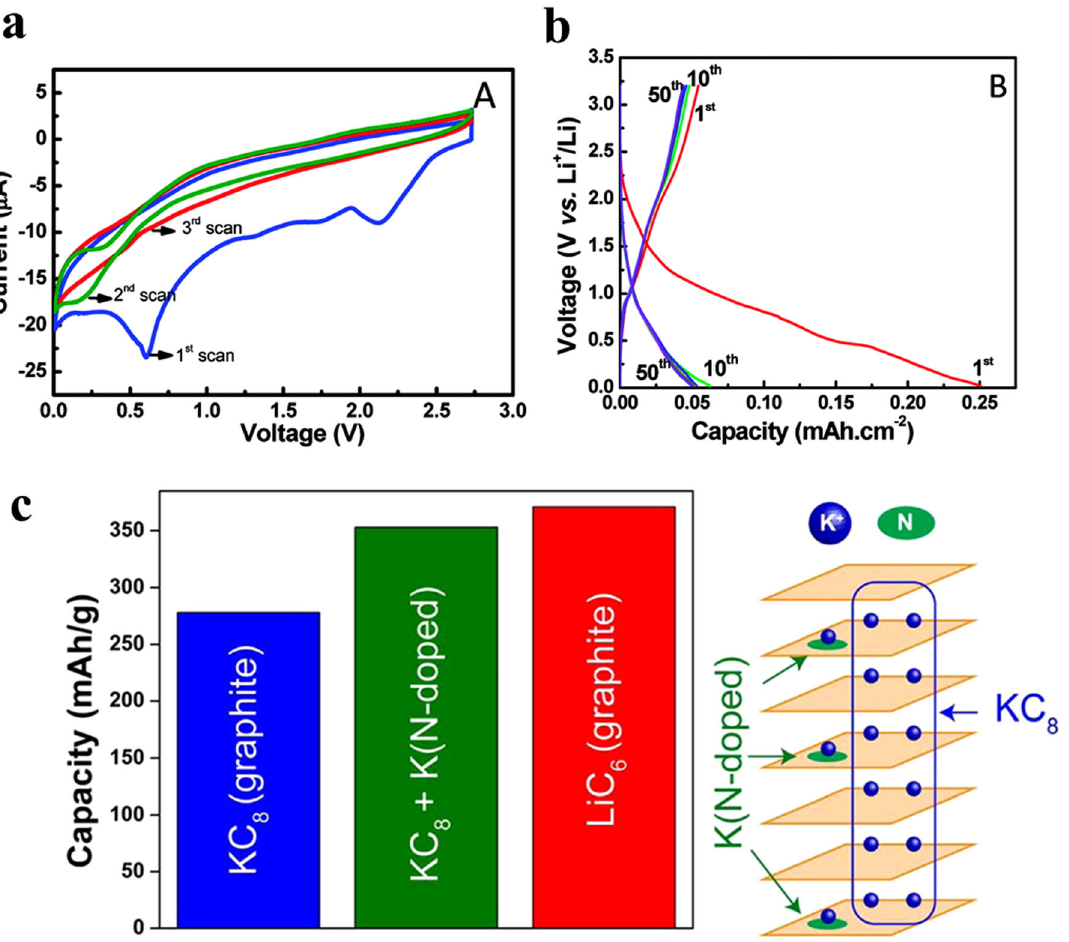
Fig. 10 Electrochemical performance. a Cyclic Li-ion battery voltammograms of the NDG/Cu foil electrode and b charge/discharge voltage pro fi les for the NDG electrode (reproduced from 53 with permission from the American Chemical Society); c K-ion battery: capacity comparison of graphene, NDG, and graphite in battery cells, with a schematic of the staging and defect storage mechanism in few-layer NDG (reproduced from 88 with permission from the American Chemical